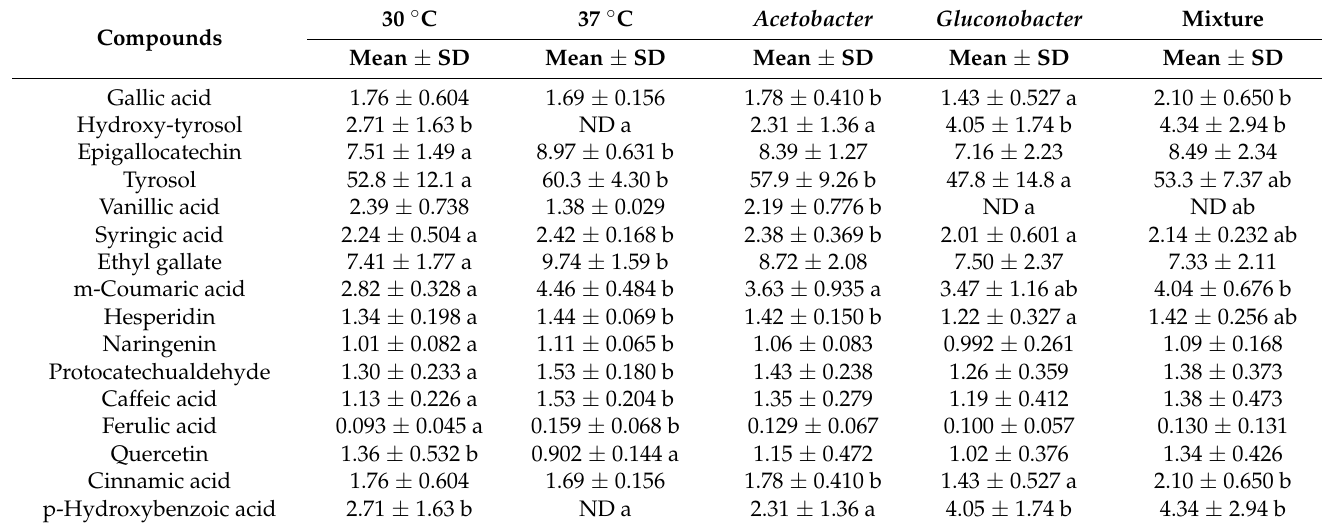
Table 6. Mean concentrations (ppm) and standard deviations of phenolic compounds identified by UPLC-DAD in prickly pear vinegar produced by surface culture method at 30 ◦ C and 37 ◦ C, and for the three types of bacteria.